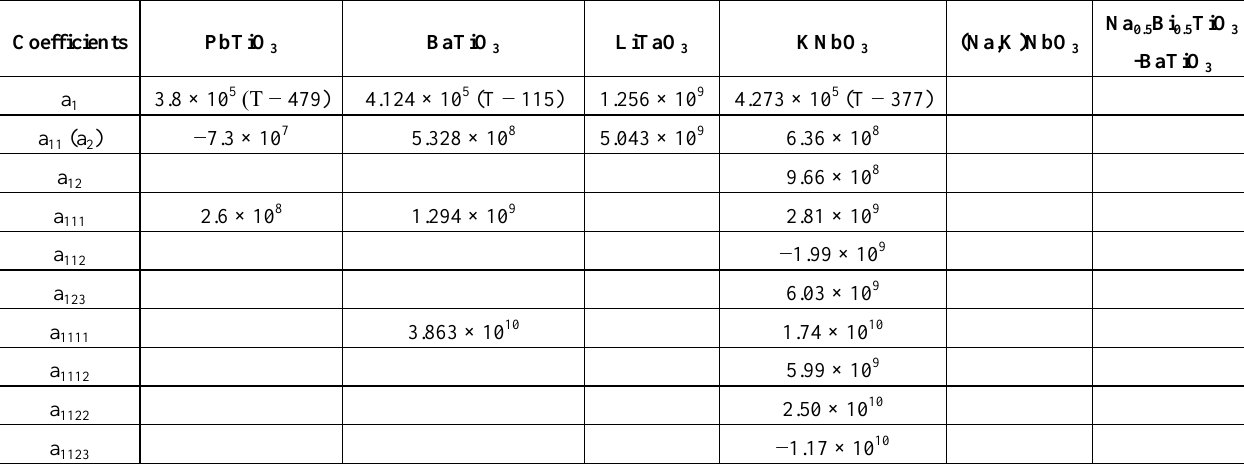
Table 2. Dielectric stiffness coefficients used for estimates (in SI units).